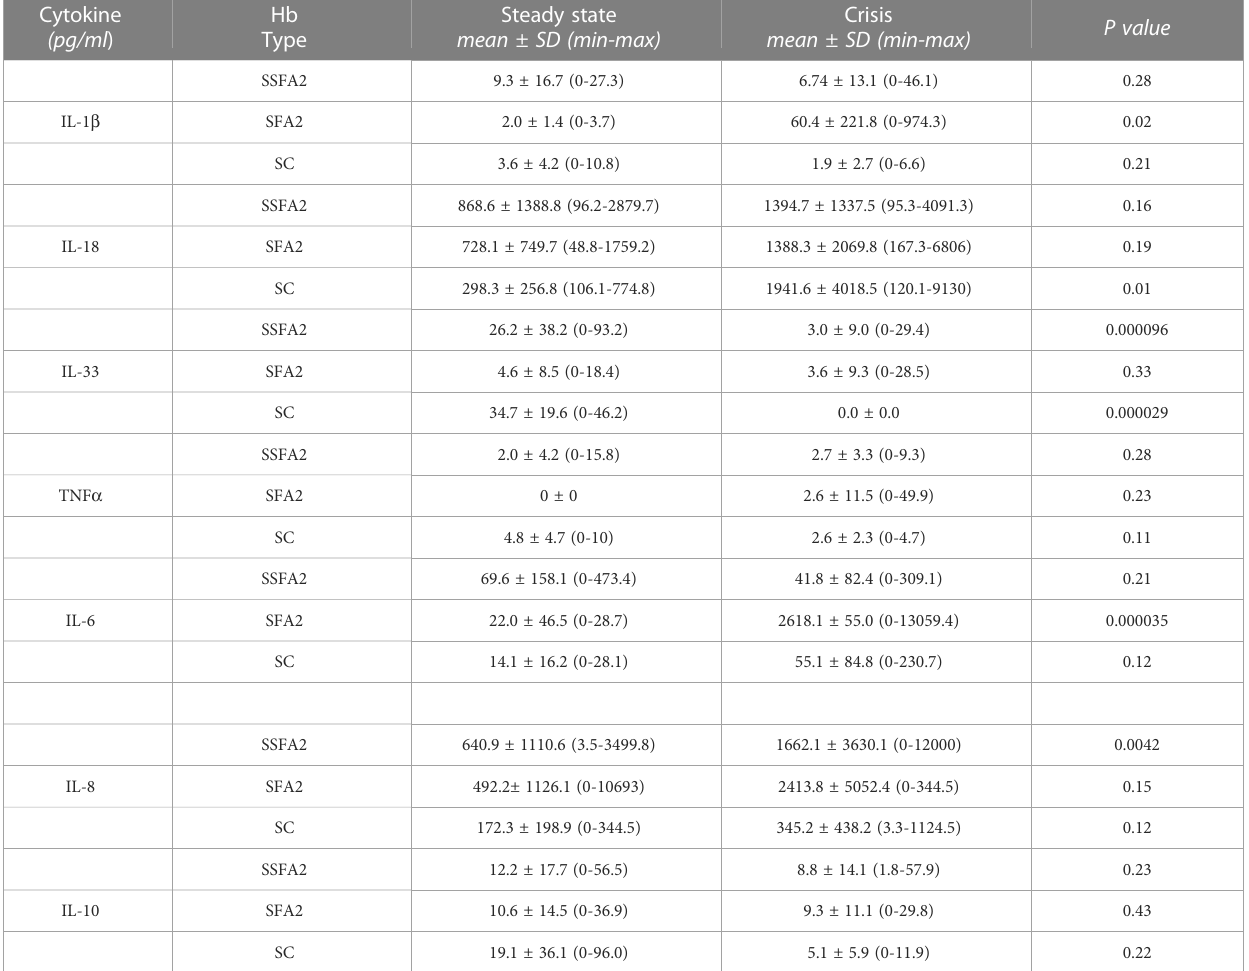
TABLE 3 Comparison of circulating cytokines for HbSSFA2, HbSFA2 and HbSC steady state and crisis patients.